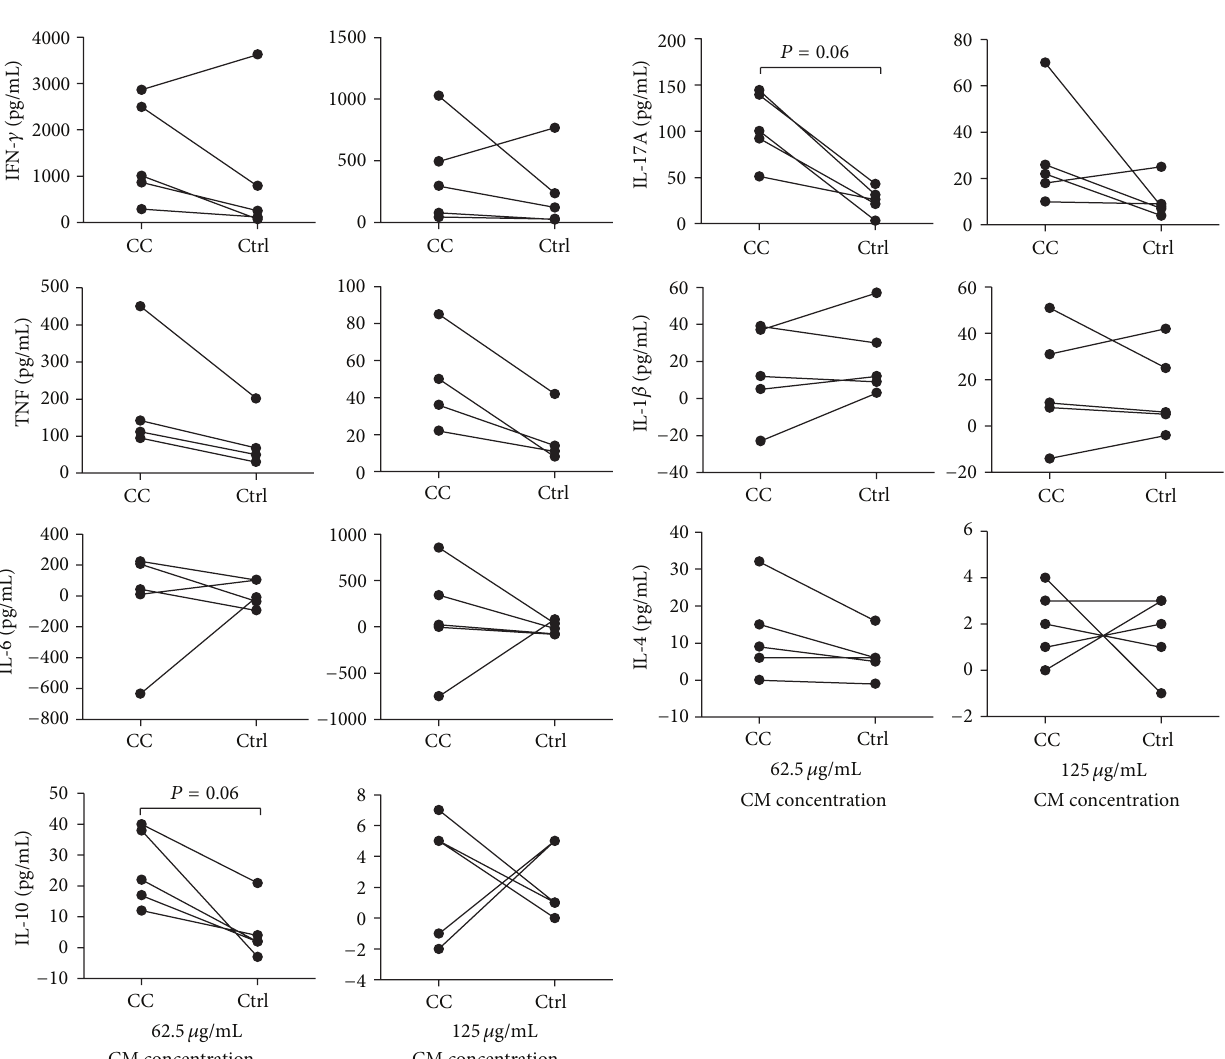
peripheral blood T cells ( 𝑛 = 5 ; for TNF analysis, 𝑛 = 4 ) cultured for 3 days in the presence of two concentrations of CM derived from lamina propria mononuclear cells (LPMC) from inflamed CC mucosa or noninflamed controls. Cytokine amounts are expressed as cytokine amounts released by peripheral T cells incubated with CM minus cytokine amounts in CM alone, in pg/mL. For each blood donor, cytokine amounts released by peripheral T cells incubated with CM from CC patients were compared with the amounts released by peripheral T cells incubated with CM from noninflamed controls. Each symbol represents data from one donor and the data points from CC and noninflamed controls for each donor are connected with a